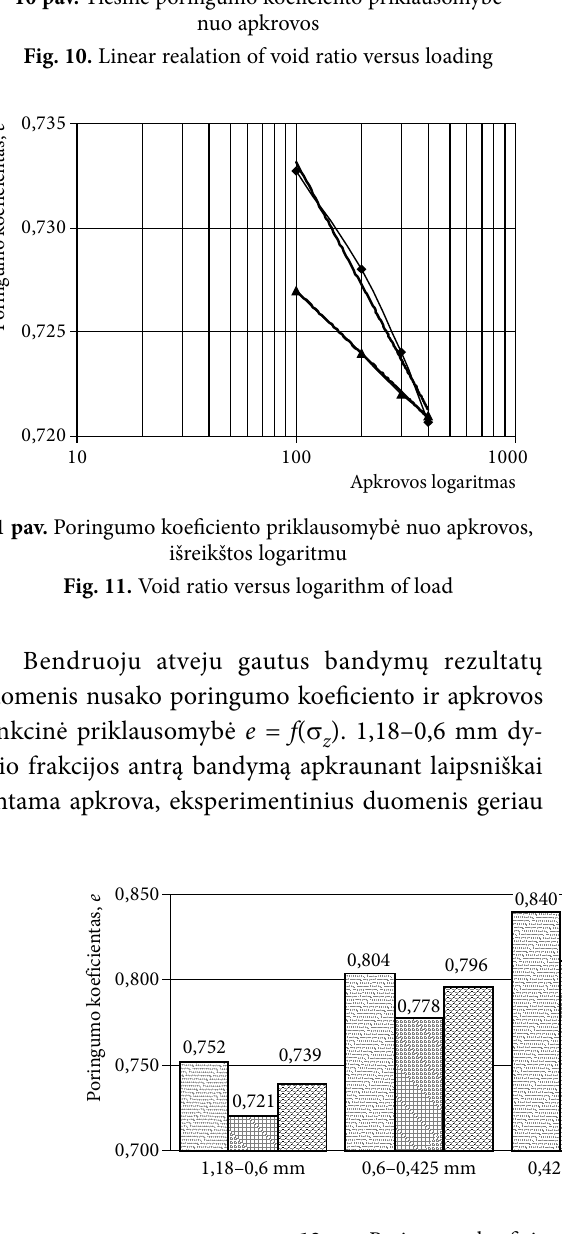
Fig. 12. Void ratio versus